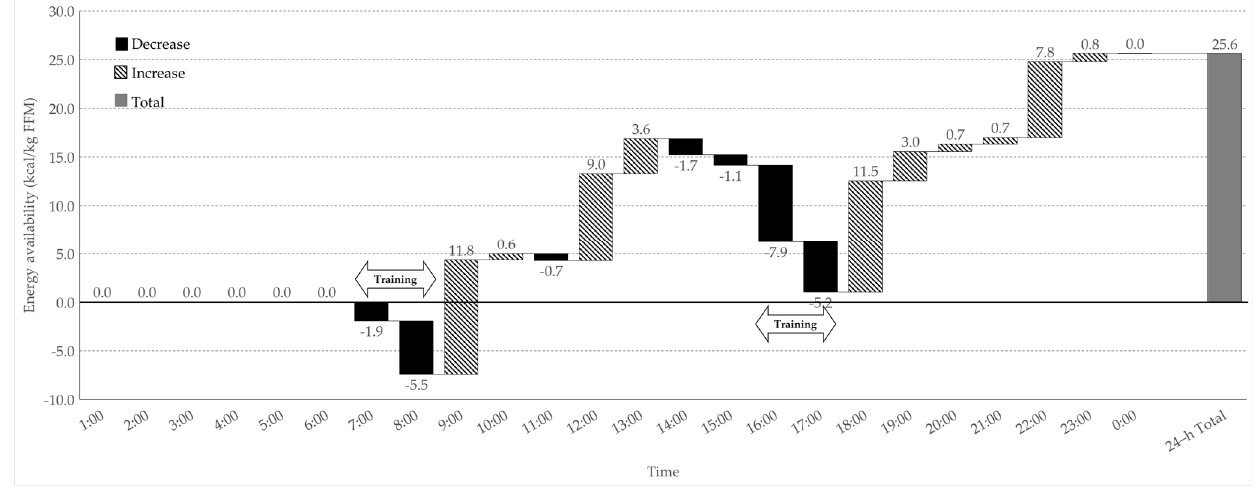
Figure 2. Hourly within-day energy availability change in the participants during the training days.